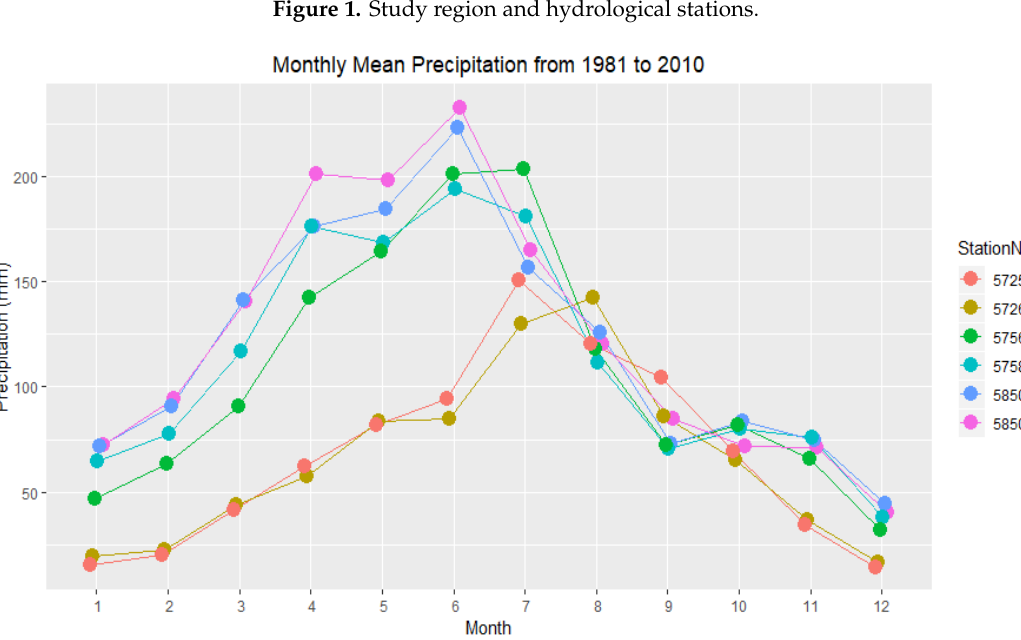
Figure 2. Monthly mean precipitation at six meteorological stations.